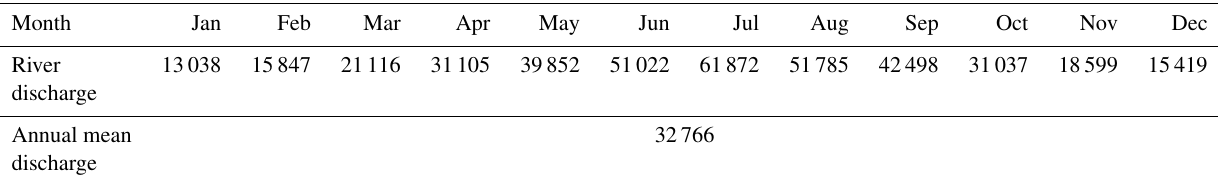
Table 3. Monthly and annually mean river discharge (m 3 s − 1 ) in